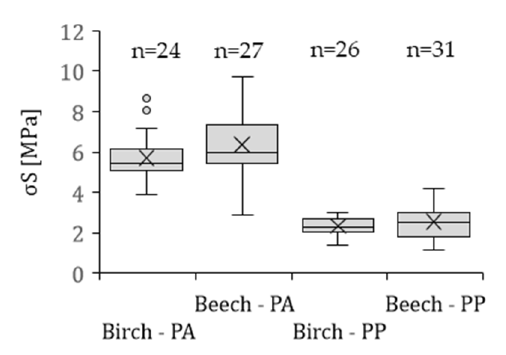
Figure 6. Average tensile shear strength σ S of birch solid wood specimens and beech solid wood overmolded with PA 6 and PP, respectively; n is the number of the samples. The whiskers show minimum and maximum values. X is the mean value. ◦ indicate values of statistical outliers and—is the median.